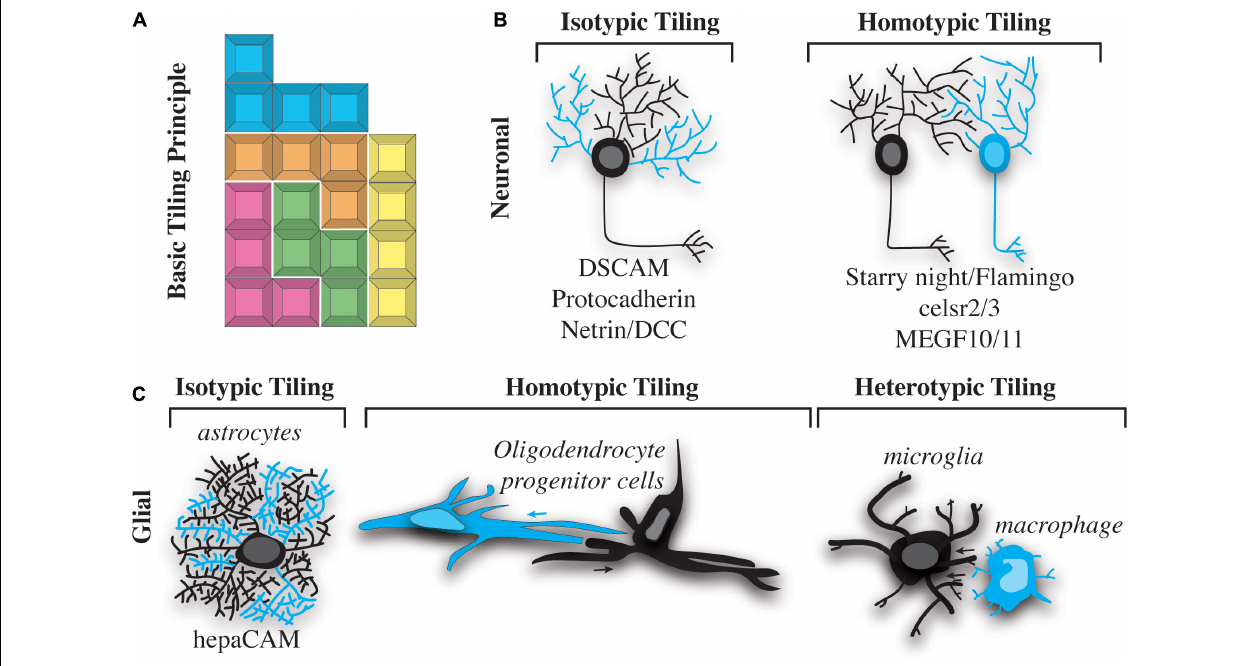
FIGURE 1 | Types of nervous system tiling. (A) “Tetris” tiling principle. Different colored blocks represent cells of different types. Different blocks fit together, but do not overlap with one another. (B) Two basic types of neuronal tiling. Isotypic tiling occurs when sister dendrites of the same neuron avoid one another. Cyan dendrites do not overlap with black on the same neuron (left). Homotypic tiling occurs when two neurons of the same type (one shown in black and the other in cyan) avoid one another and their black dendrites do not overlap (right). A selection of molecules that facilitate these types of tiling are listed below the illustrations. (C) Three basic types of tiling occur in glial cells. Isotypic tiling occurs in astrocytes when branches of the same cell (cyan vs. black) avoid one another. hepaCAM is involved in astrocytic typing (left). Oligodendrocyte progenitor cells (OPCs) exhibit homotypic tiling whereby OPCs of the same type (cyan vs. black) avoid one another. The direction of this avoidance is shown by cyan and black arrows (center). Heterotypic tiling occurs when two different types of glial cells avoid one another. In this case a black microglial cell is shown avoiding a cyan macrophage (right).